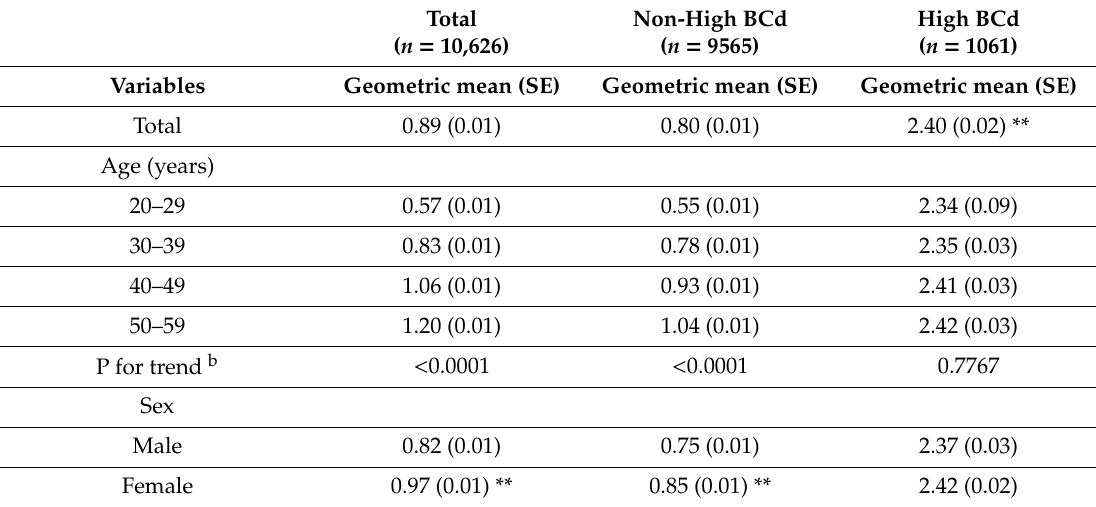
Table 2. Distributions of cadmium levels ( µ g / L) of general and clinical characteristics according to BCd level a